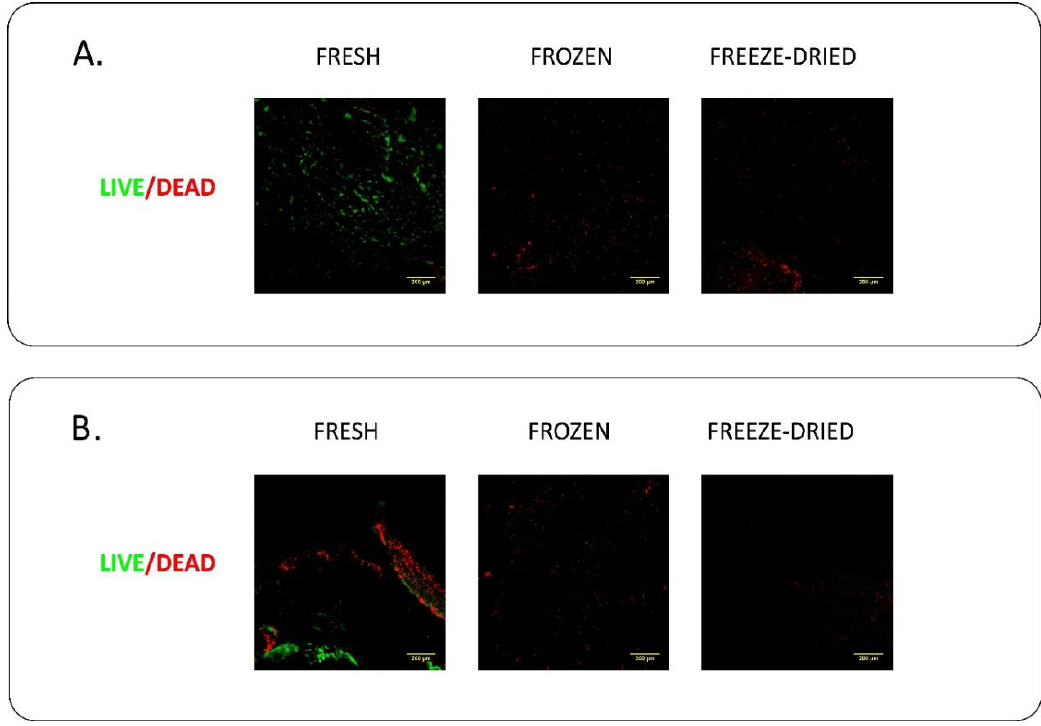
Figure 5. Live/dead cell imaging of the membranes by confocal microscope. Cellular viability of leukocytes embedded into the GT ( A ) and HI ( B ) PRF. Living cells were only observed in fresh samples.